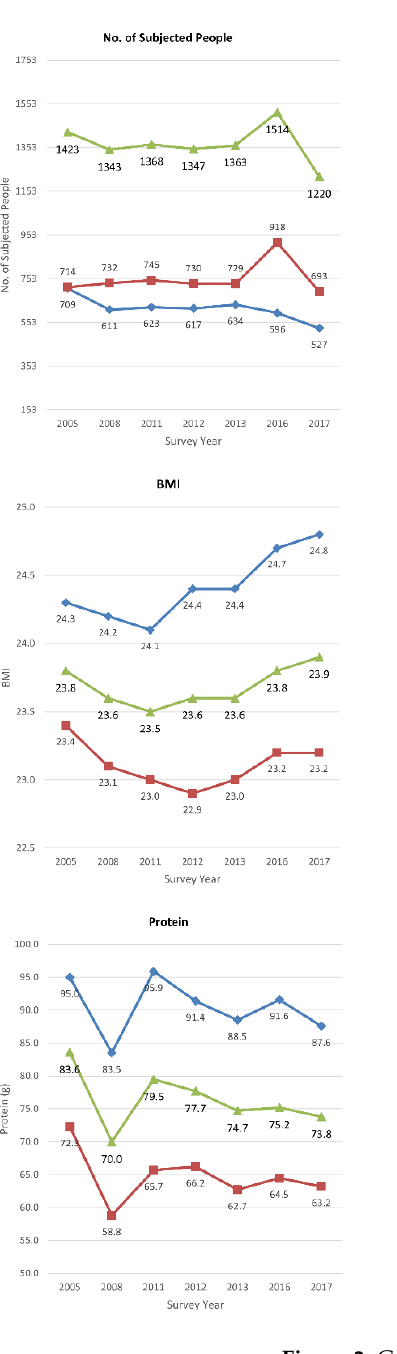
Figure 2. General characteristics of the subjects with AM from the 2005 to 2017 surveys.